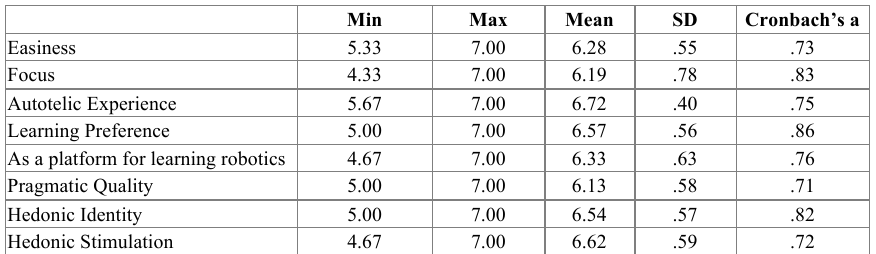
Table 2. Attitudes Questionnaire